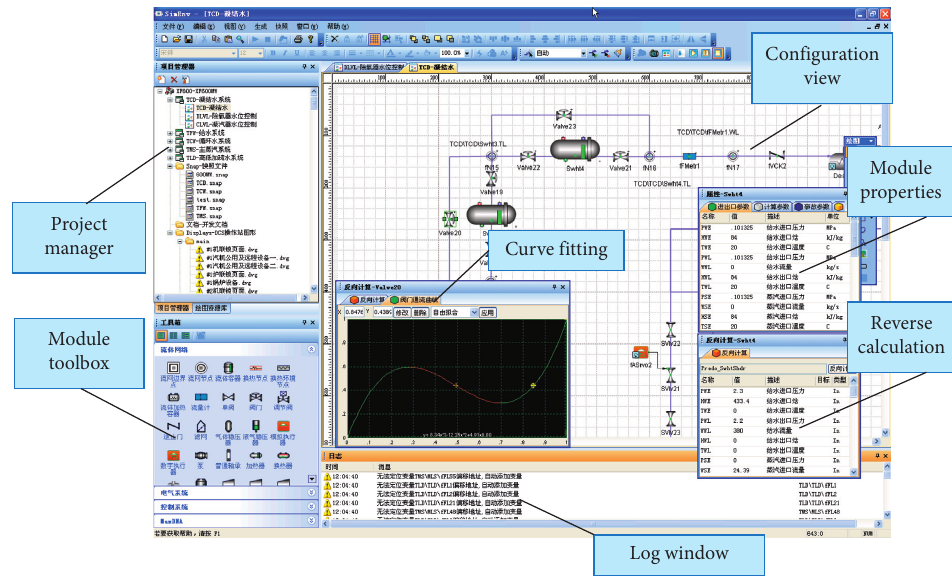
Figure 4: Interface of vPower